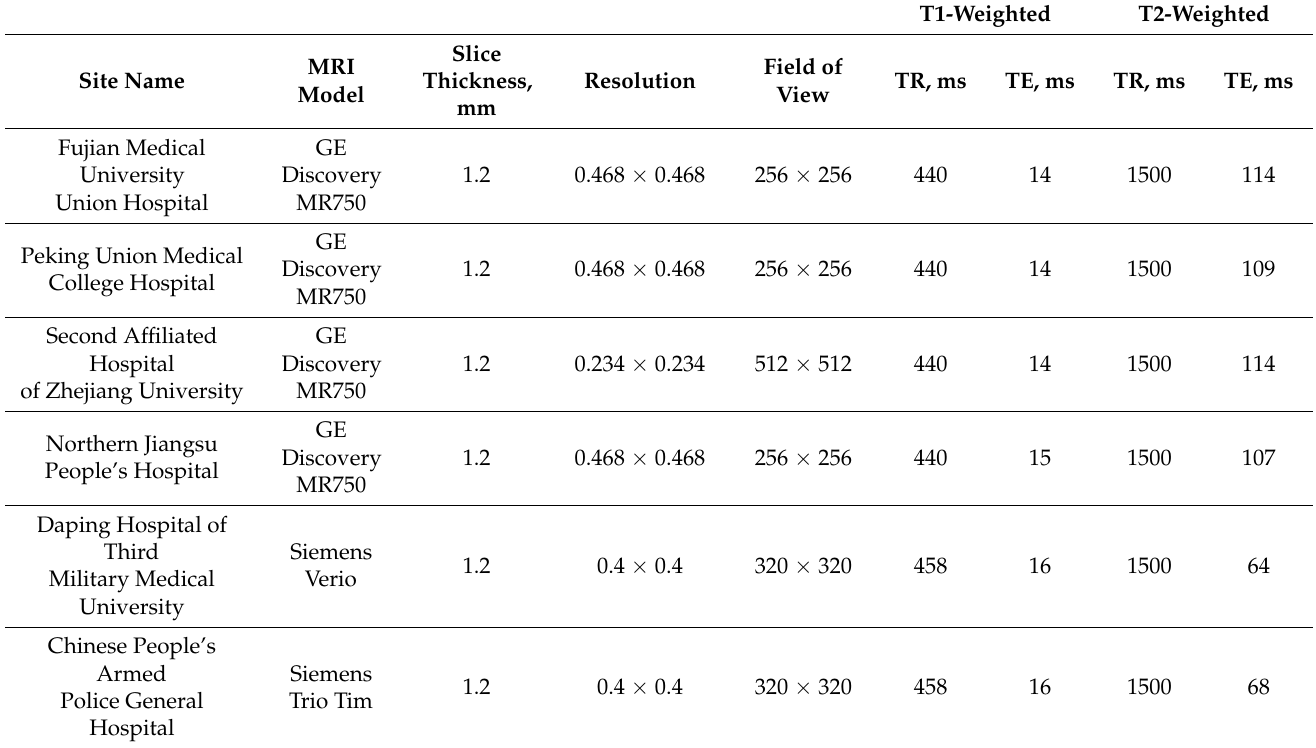
Table 3. MRI models and parameters for phantom T1-weighted